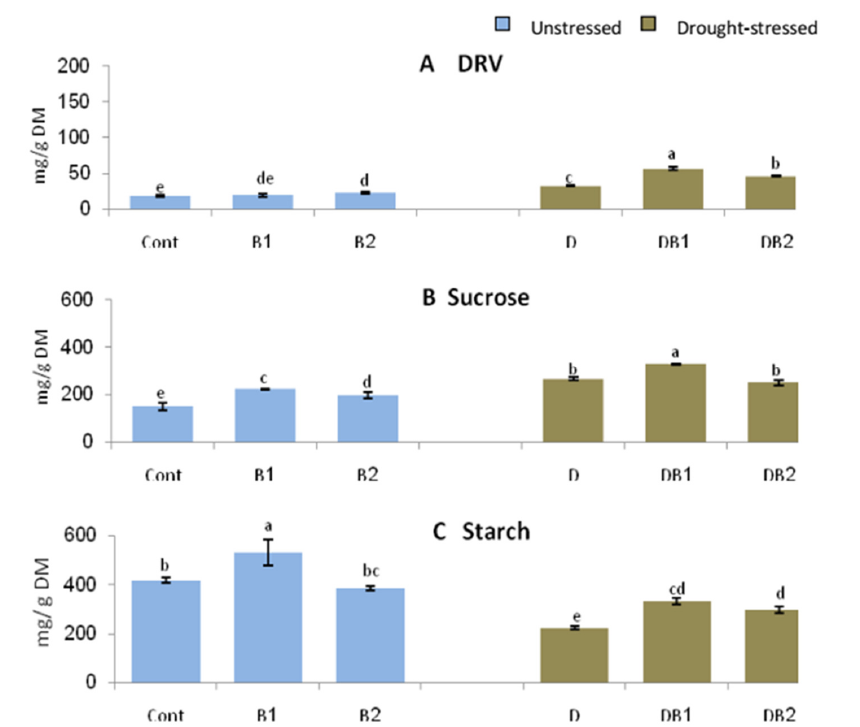
Figure 1. Effect of bacterial inoculation with A. brasilense NO40 (B 1 ) and S. maltophilia (B 2 ) on the contents of total reducing sugars (DRV) (A) , sucrose (B) and starch (C) (mg/ g DM) of the yielded-grains of Triticum aestivum (cv. G9) plants grown in sandy soil, under unstressed (irrigated every 5 days) and drought-stressed (irrigated every 10 days) conditions. Error bars represent the standard deviation between 3 replicas. Treatments with identical letters are not significant at P ≤ 0.01. Cont. = the unstressed- uninoculated control; D= the drought-stressed-uninoculated treatment, B (1-2)= the unstressed- inoculated treatments and DB(1-2) = the drought-stressed -inoculated